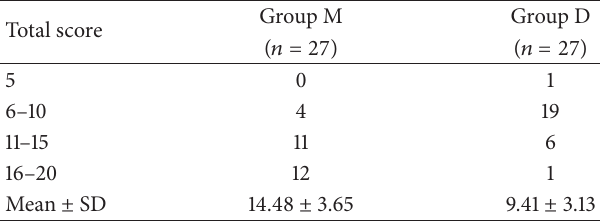
Table 3: Comparison of composite score (total score).